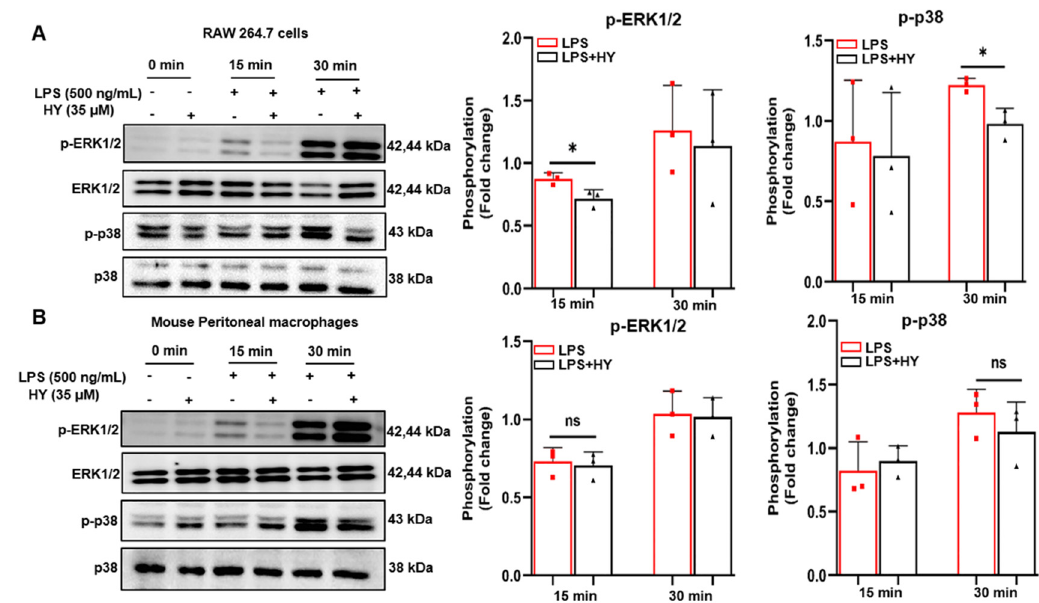
Figure 7. ( A ) Western blot analysis for the inhibitory effect of hyssopuside (HY) on the phosphorylation of mitogen-activated protein kinases (MAPKs), including extracellular signal-regulated kinase 1/2 (ERK1/2) and p-38 in LPS-induced RAW 267.4 cells treated with 35 µM HY for 15 or 30 min and quantitative of phosphorylation ERK1/2 and p-38. ( B ) Western blot analysis for the inhibitory effect of HY on the phosphorylation of MAPKs, including ERK1/2 and p-38 in LPS-induced mouse peritoneal macrophages treated with HY µM 35 for 15 or 30 min and quantitative of phosphorylation ERK1/2 and p-38. Data are representative of three replicates and shown as mean ± SD. * p < 0.05 versus the LPS group, ns, no significance.